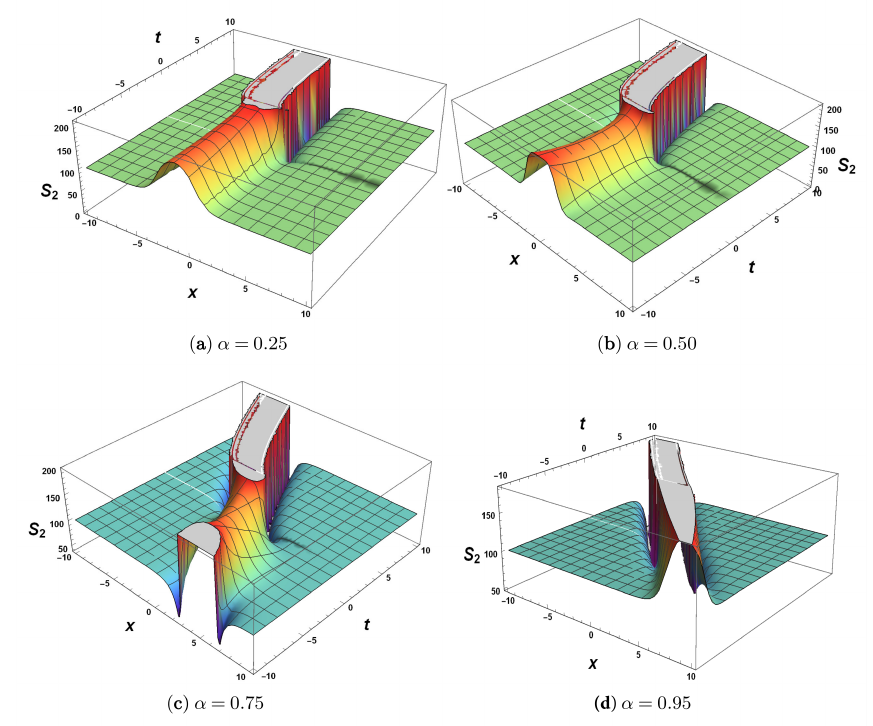
Figure 6. A 3D graphical representation for S 2